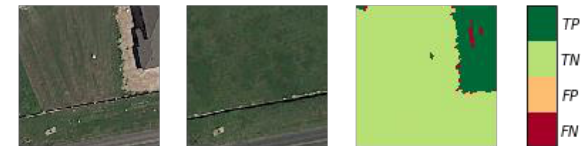
Figure 10: Change Detection Prediction Example Using UNet++.